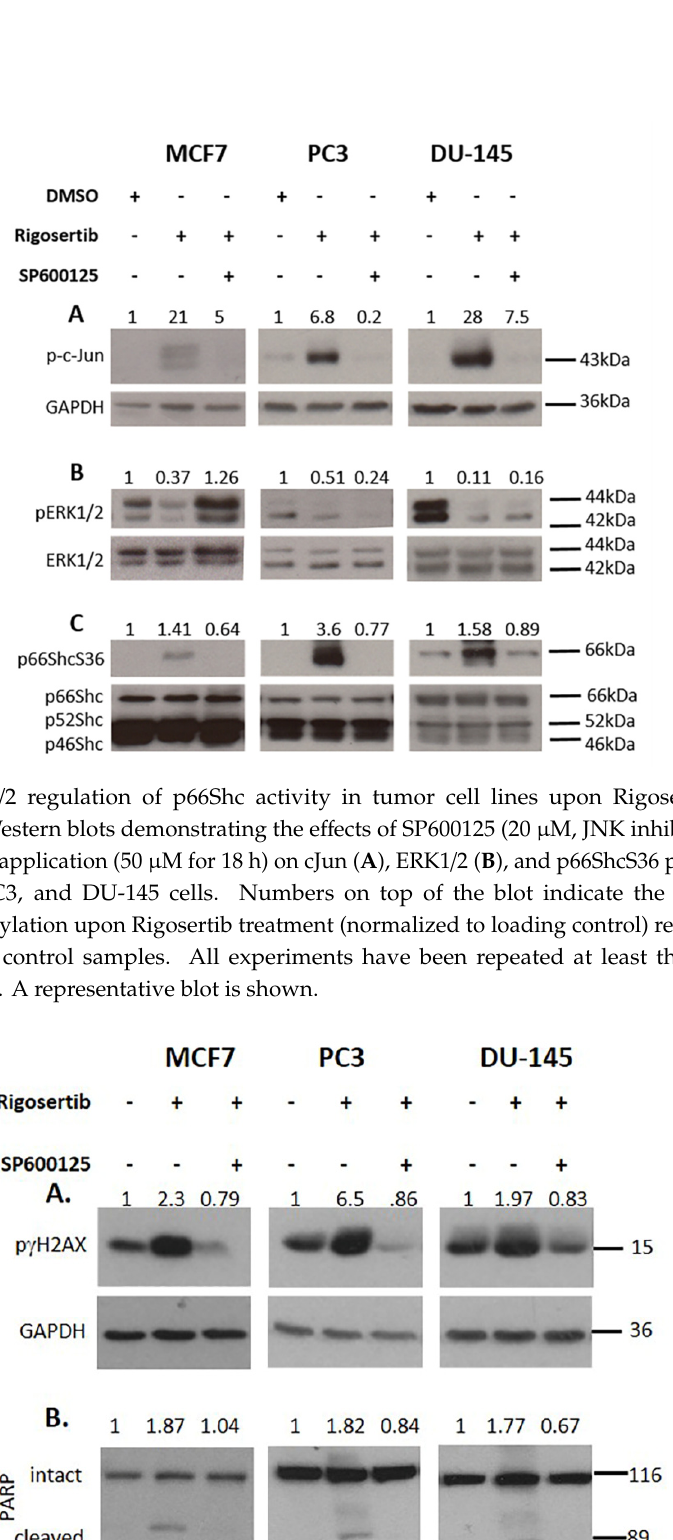
Figure 5. During the submission of the revised manuscrip an incorrect version of this Figure has been submitted, The figure inserted now is as requested by the reviewers. p66Shc is necessary for Rigosertib-mediated tumor cell killing. Representative Western blots demonstrate γ H2AX phosphorylation and PARP cleavage in p66Shc-HA-His transiently transfected MCF7 cells treated with Rigosertib (50 μ M) or DMSO for 18 h. All experiments have been repeated at least three times with consistent results. A representative blot is shown. 4. Discussion Rigosertib was discovered in a phenotypic screen for molecules that induce mitotic cell-cycle arrest in tumor cells while sparing non-transformed cells [17]. The direct target of Rigosertib remains elusive, and inhibition of PLK1 [17] and PI3K [18] have been reported. Antitumor activities also